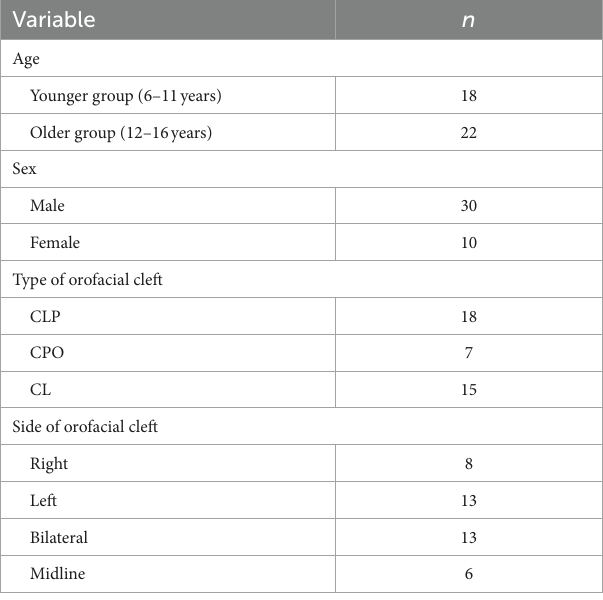
TABLE 5 Demographical data of the orofacial cleft group. Variable